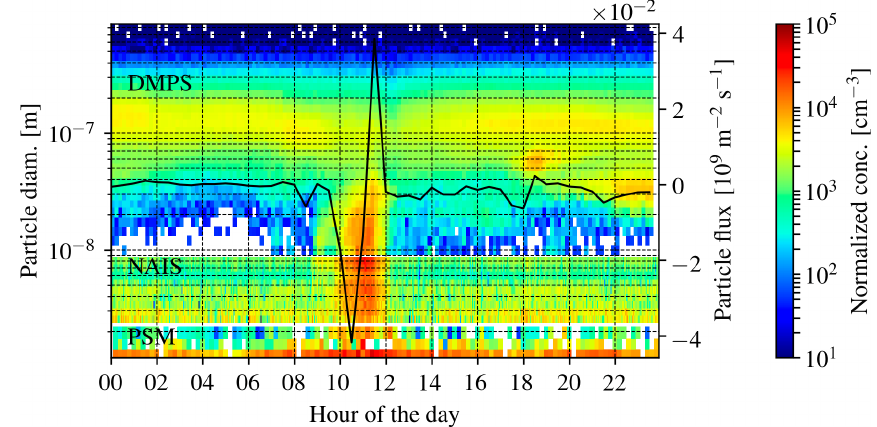
Figure 4. The particle number-size distribution in the range of 1–1000nm (composite of PSM, NAIS and DMPS data; see the Methods section for instrument details) measured at the SMEAR II station on 21 August 2015. The black line is the vertical flux of particles greater than 10nm measured above the forest canopy (23m height, negative sign means downward flux).